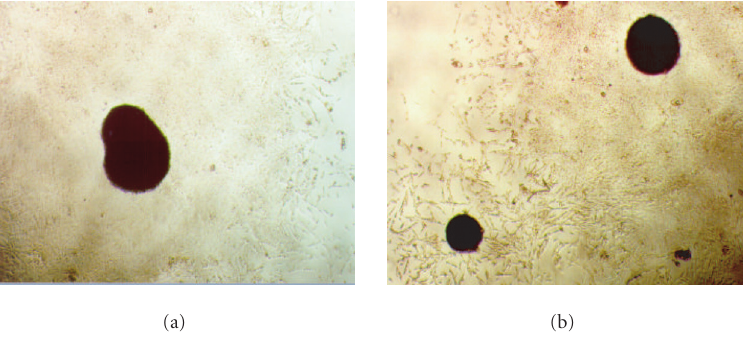
Figure 2. Phase-contrast microscopy. (a) Nodule surrounded by polygonal cells formed by previously dedi ff erentiated chondrocytes cultured with crude protein extract, OM × 10. (b) Very small nodules produced by the addition of small protein extract to previously dedi ff erentiated chondrocytes. Their cells soon detach from the aggregate to remain free in the culture medium, OM × 10.